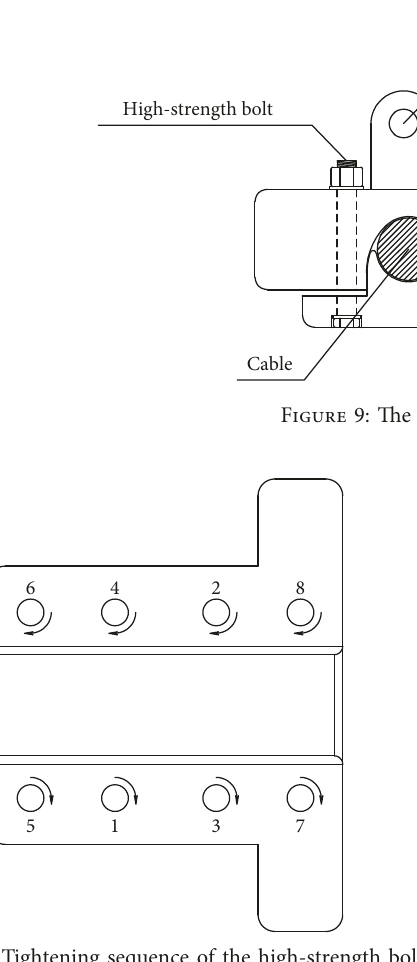
Figure 10: Tightening sequence of the high-strength